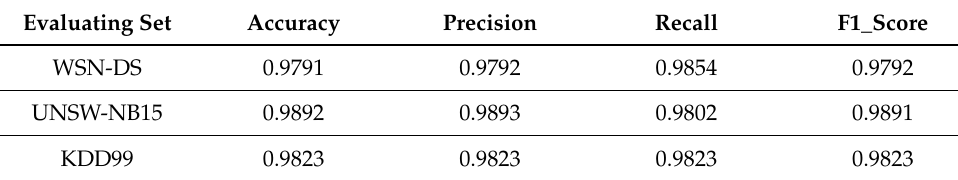
Table 9. Metrics.